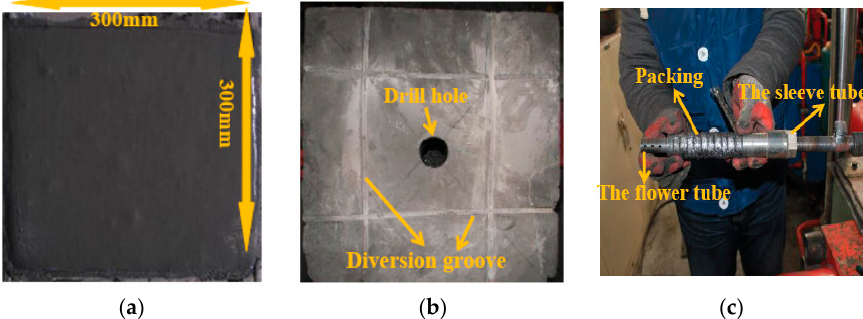
Figure 1. The process of specimen preparation: ( a ) Casting large the oil shale sample with concrete; ( b ) Drill hole and diversion groove of the processed sample; ( c ) Structure of the heat injection tube.